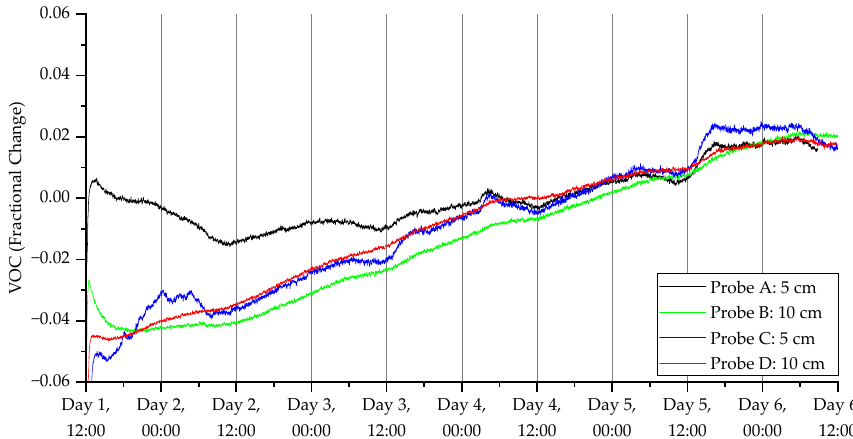
Figure 12. VOC measurements for the deployment in Warwick campus woodland. Data collection commenced on 11 November 2021 at 12:40 (24 h time).